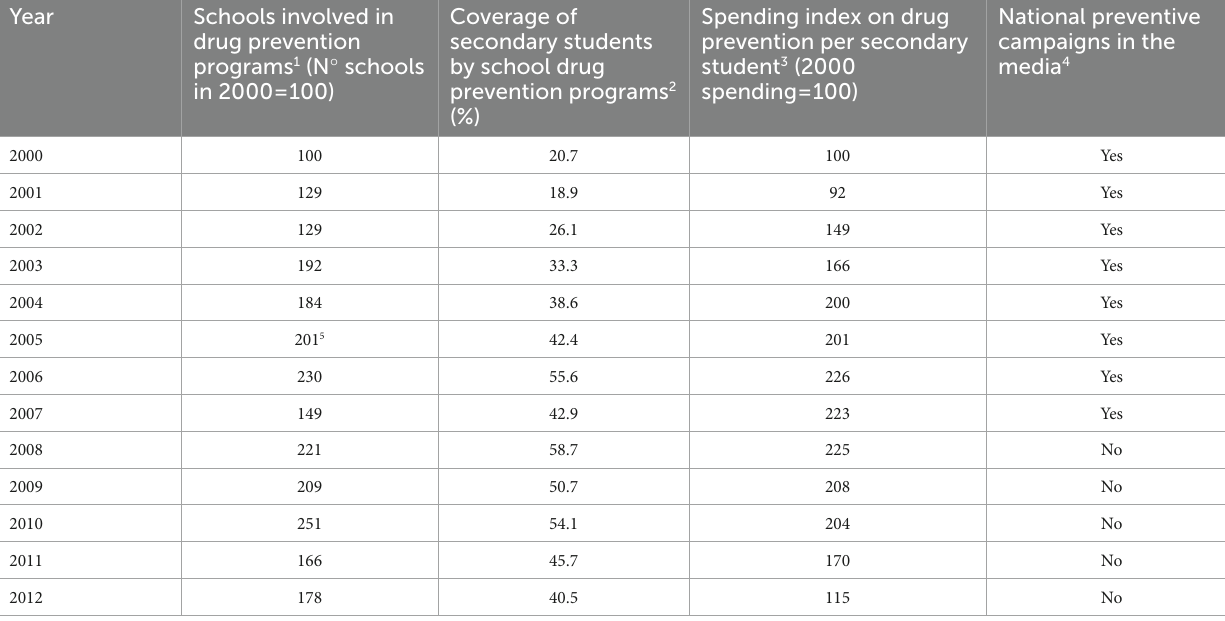
TABLE 5 Evolution of indicators on drug prevention interventions implemented by the public administration in Spain,